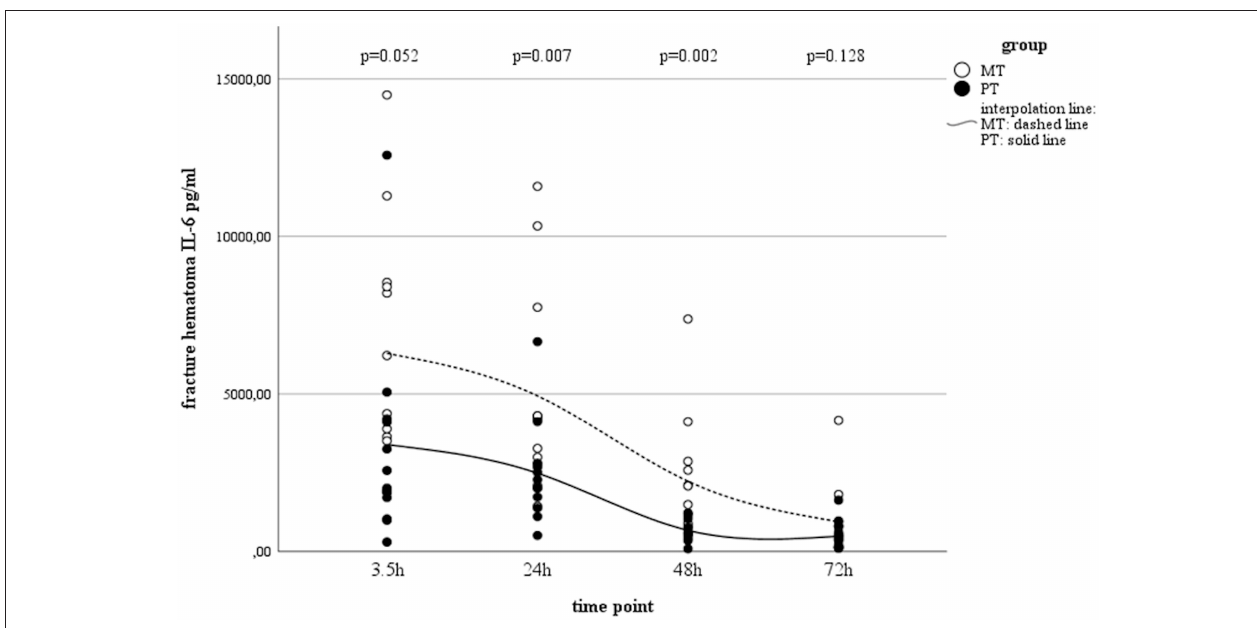
FIGURE 1 | IL-6 concentrations in fracture hematoma between groups and different time points (PT, Polytrauma; MT, Monotrauma; pg/ml, picogram per milliliter; h, hours).